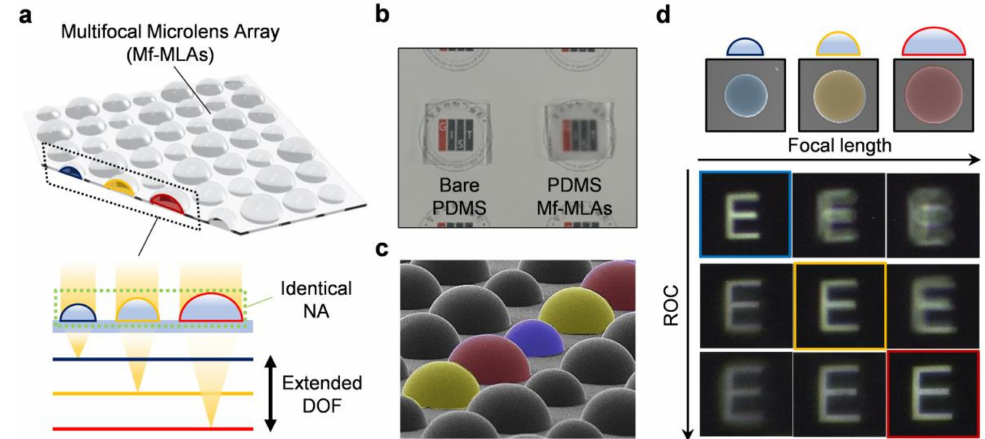
Figure 1. ( a ) Concept schematic of Multifocal Microlens Arrays (Mf-MLAs) with three di ff erent radii of curvature (RoC) for an extended depth of field. ( b ) Photographs of bare poly-dimethylsiloxane (PDMS) and a replicated PDMS Mf-MLAs sample. ( c ) 40-degree tilted view SEM image. ( d ) Microscope images of letter “E” placed on object distances corresponding to each lens’ focal